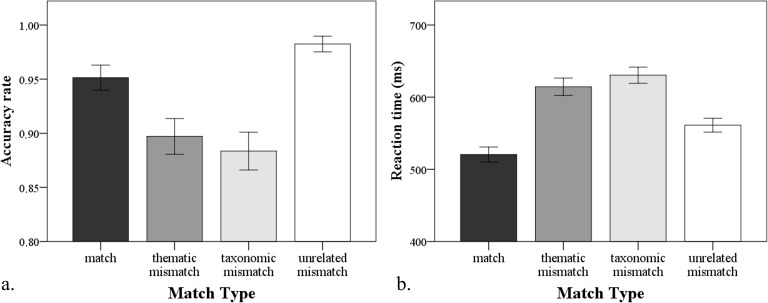
Accuracy rate (a) and average reaction time (b) across the four match types. Error bars represent confidence intervals.